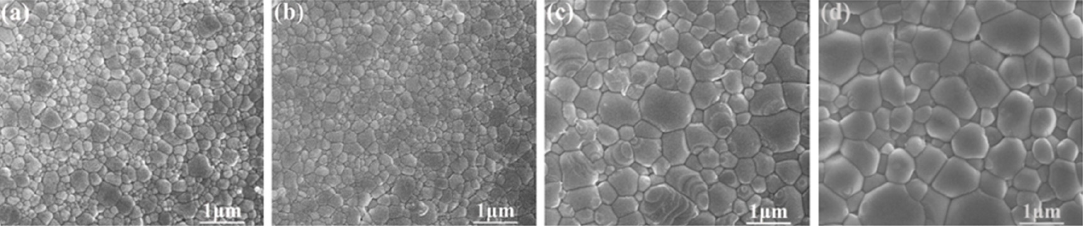
Figure 2. The microstructure of Ba(Zn 1/3 Ta 2/3 )O 3 (BZT) ceramics by spark plasma sintering at different temperature for 10 min with 30 MPa applied pressure: ( a ) 1300 ° C; ( b ) 1350 ° C; ( c ) 1400 ° C; ( d ) 1450 ° C.